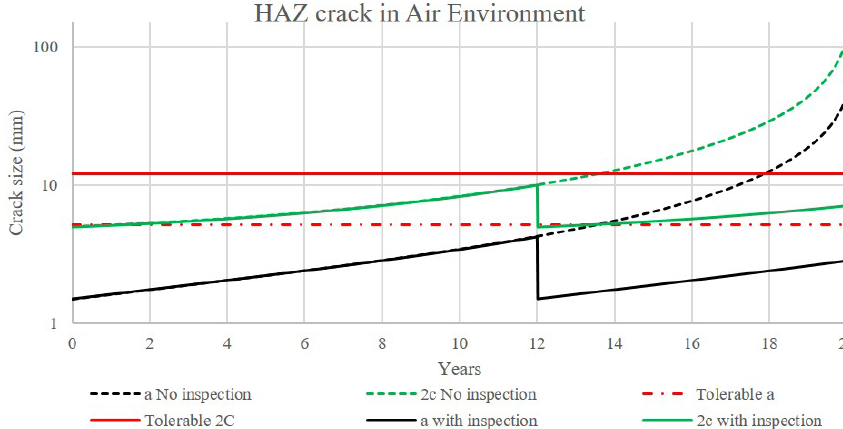
Figure 21. Crack growth curves for propagation in HAZ and in the air environment.